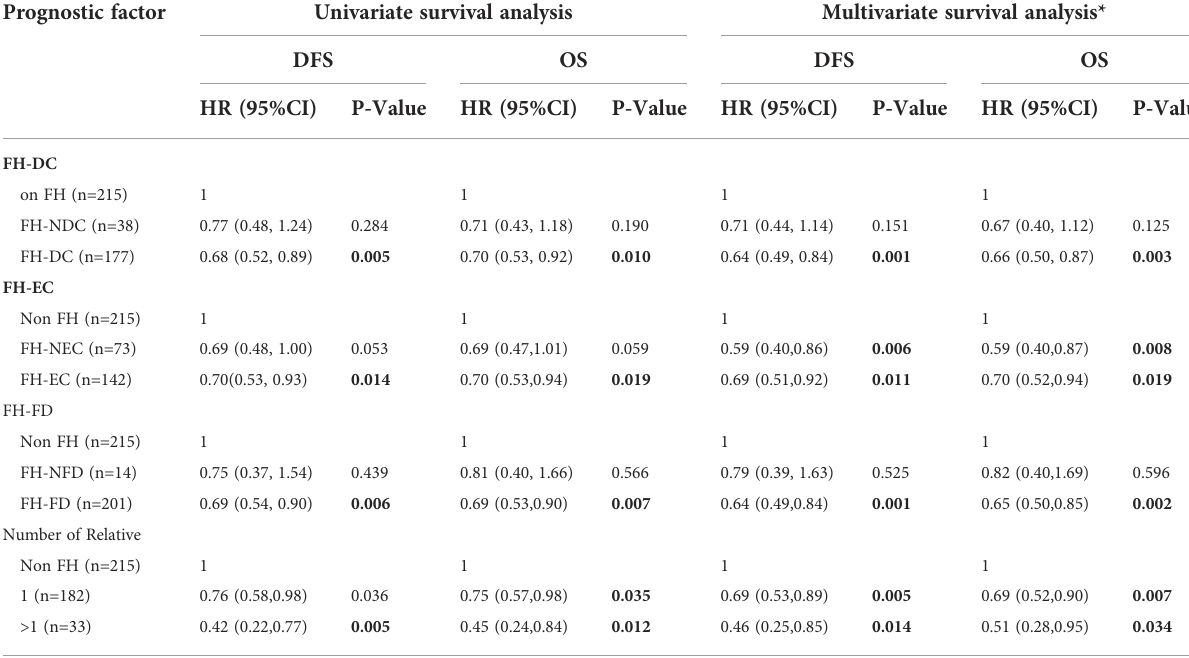
TABLE 3 Univariate and multivariate survival analysis for different types of family history of cancer in ESCC after PSM. Prognostic factor Univariate survival